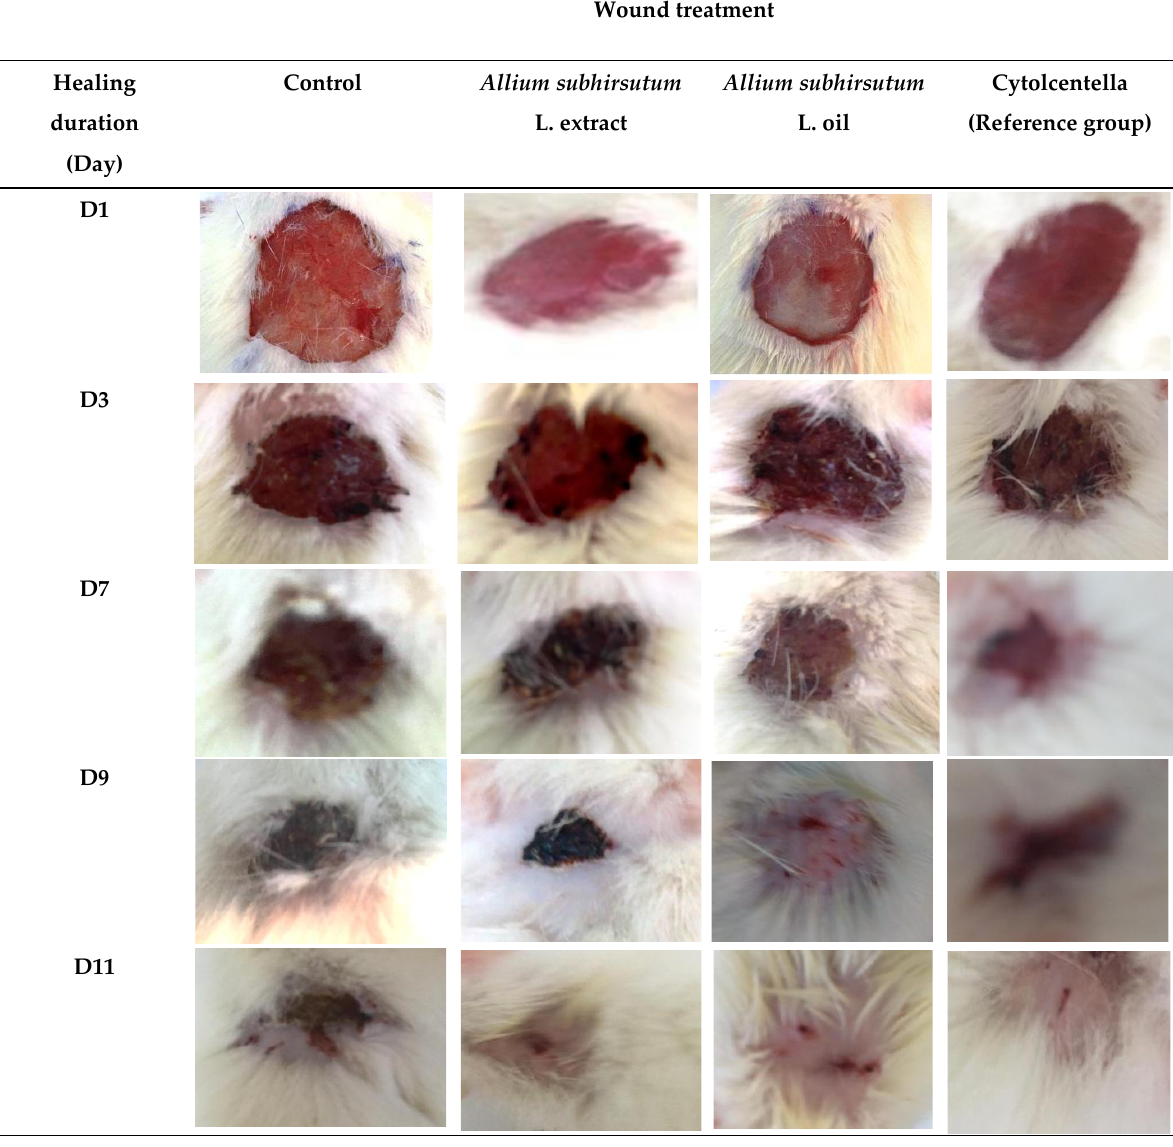
Figure 1. Photographic illustrations of wound healing process in the different experimental groups on 1, 3, 7, 9 and 11 days post-wounding.